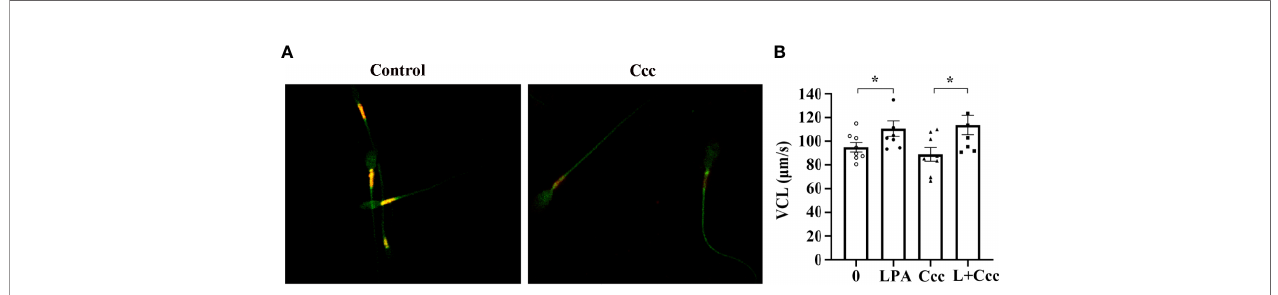
FIGURE 5 | Effect of mitochondrial uncoupling on LPA-stimulating sperm motility. (A) The activity of mitochondria uncoupled by 10 µM CCCP (Ccc) was measured by 5 µM JC-1. Microscopic analysis showed the change of red/orange fl uorescence of sperm treated with CCCP. (B) Spermatozoa were treated with 100 µM LPA (L) for 1 h in the absence or presence of 10 µM CCCP (Ccc), an uncoupler used to inhibit mitochondrial ATP production. The curvilinear velocity (VCL) of sperm motility was assessed by computer-assisted sperm analysis. Data are presented as mean ± SEM. n = 8. * p < 0.05 compared with the corresponding control (0 µM).